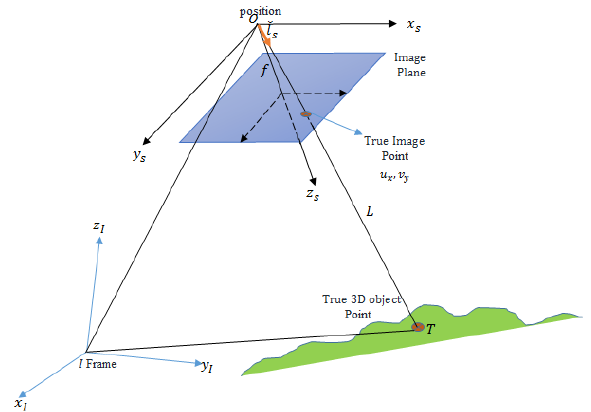
Figure 5: The orientation of the sensor frame ( S frame) relative to the inertial coordinate frame ( I